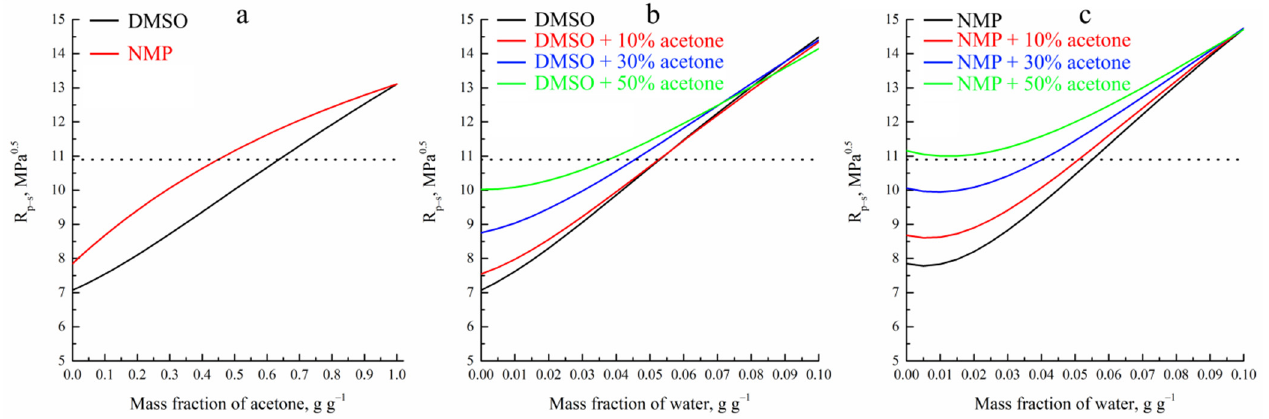
Figure 2. The distance in Hansen space between PAN and binary mixtures of DMSO and NMP with acetone ( a ); binary or pseudobinary mixtures of DMSO (DMSO + acetone) ( b ) and NMP (NMP + acetone) ( c ) with water. A dashed horizontal line corresponds to PAN solubility radius.